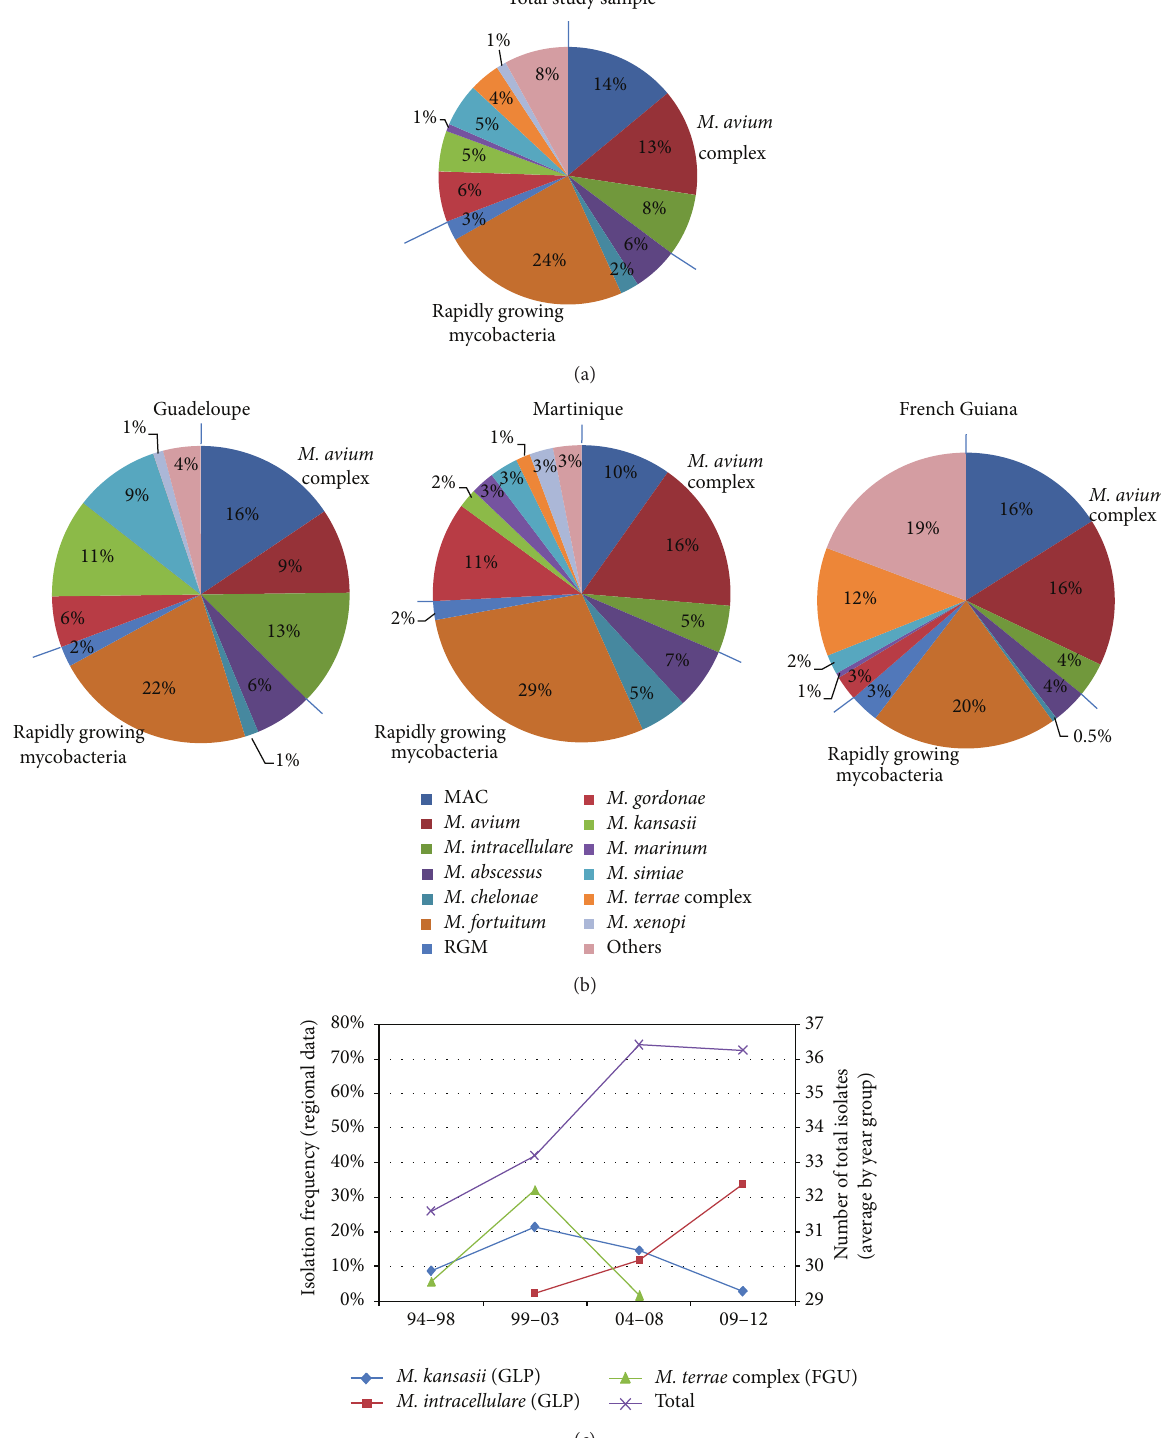
Figure 1: Distribution patterns of nontuberculous mycobacteria isolated from clinical samples in the three French departments of the Americas from 1994 to 2012. (a) Total study sample 𝑛 = 651 strains (one isolate per species per patient); (b) distribution of strains per department, that is, Guadeloupe 𝑛 = 270 , Martinique 𝑛 = 194 , and French Guiana 𝑛 = 187 ; (c) mean isolation frequency for M. kansasii and M. intracellulare in Guadeloupe and for M. terrae complex in French Guiana versus total isolates during study periods of 1994–1998, 1999–2003, 2004–2008, and 2009–2012 (numbers are shown as average number per year on secondary 𝑥 -axis; mean values are illustrated to counterbalance the fact that the last interval consisted of four